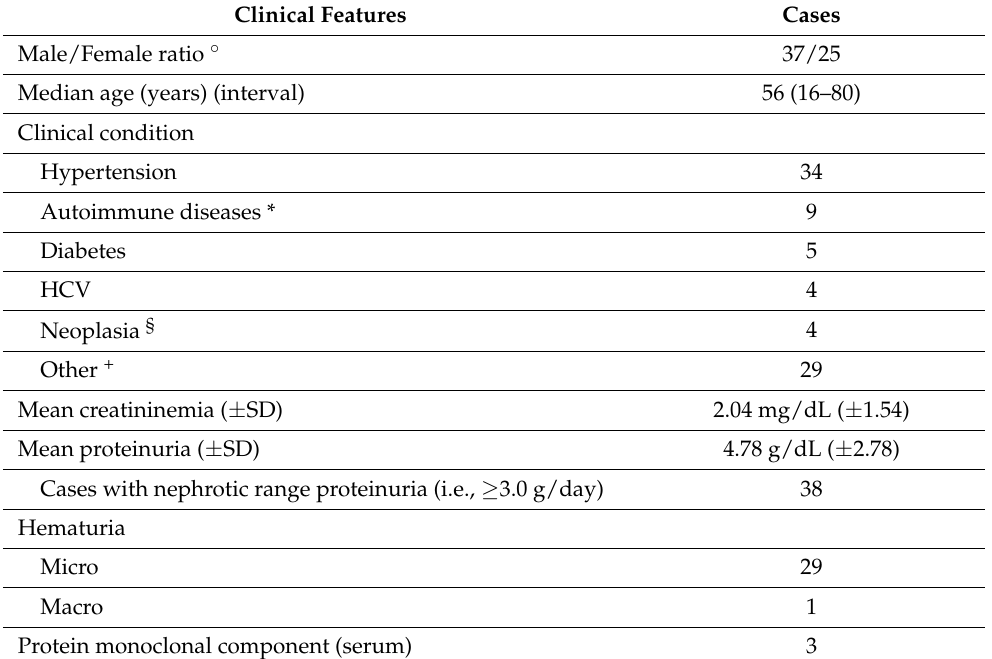
Table 2. Clinical features of the FGN